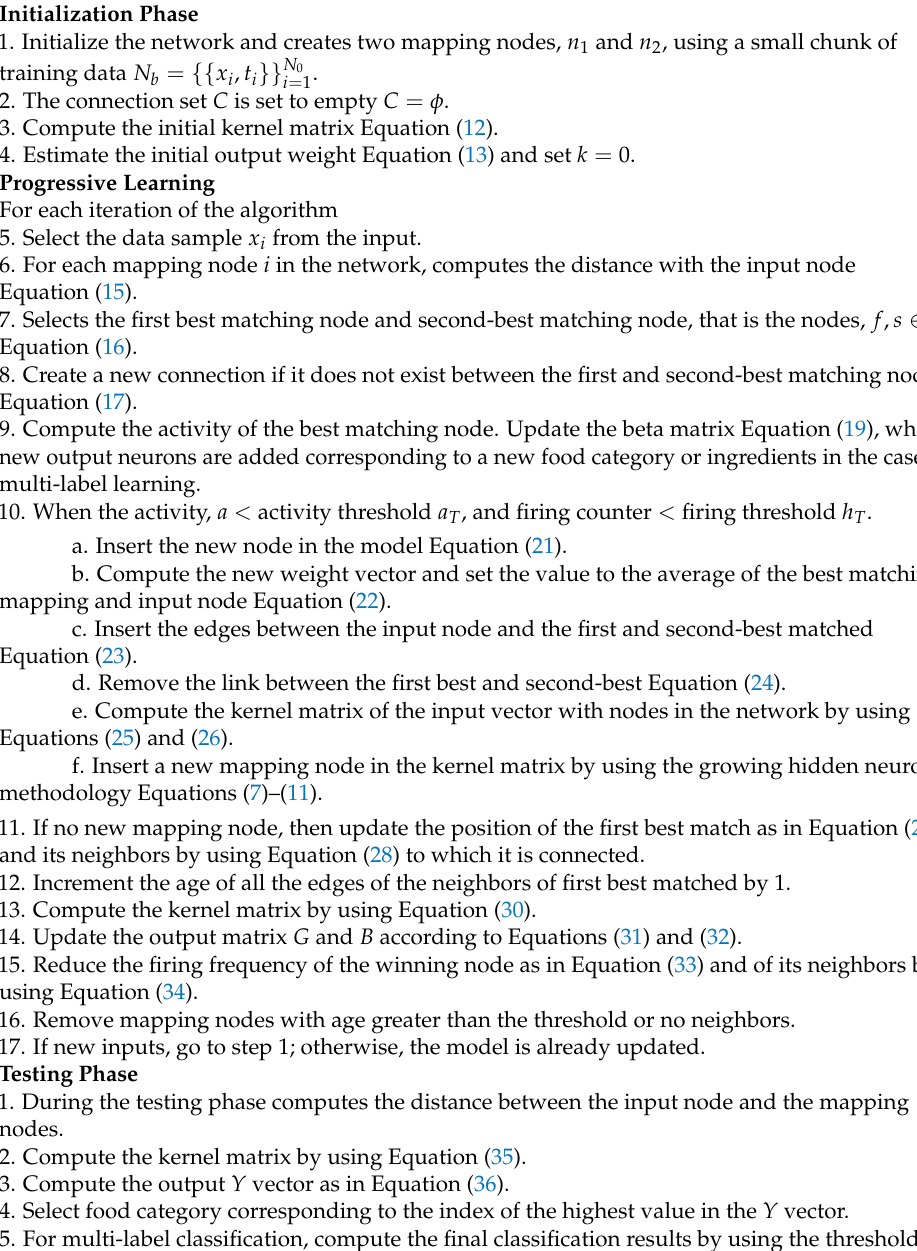
Table 1. Proposed PKELM for food categorization and ingredient